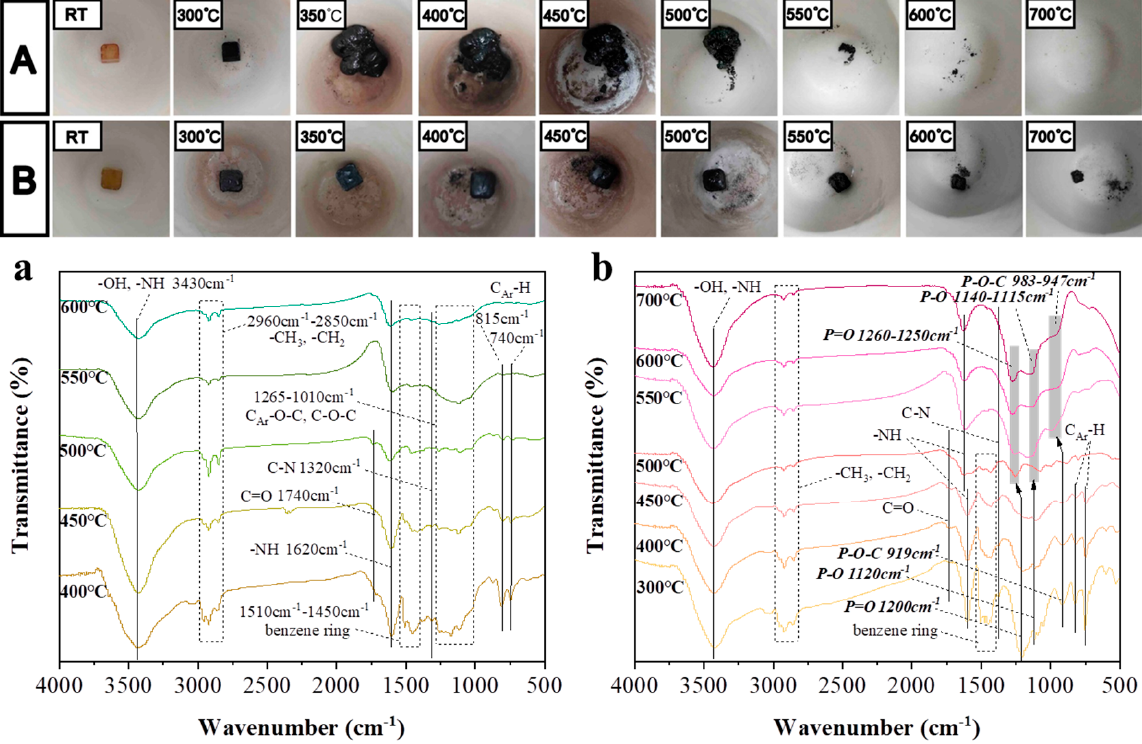
Figure 5. Digital photographs and residual char FTIR spectra of EP ( A , a ) and 2%HPDAl/EP ( B , b ) after being maintained at different temperatures for 15 min in a muffle furnace.